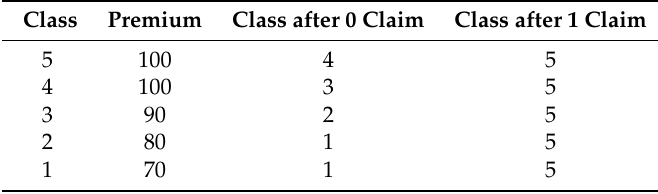
Table 2. Transition rules for the ‘Spanish Bonus-Malus’